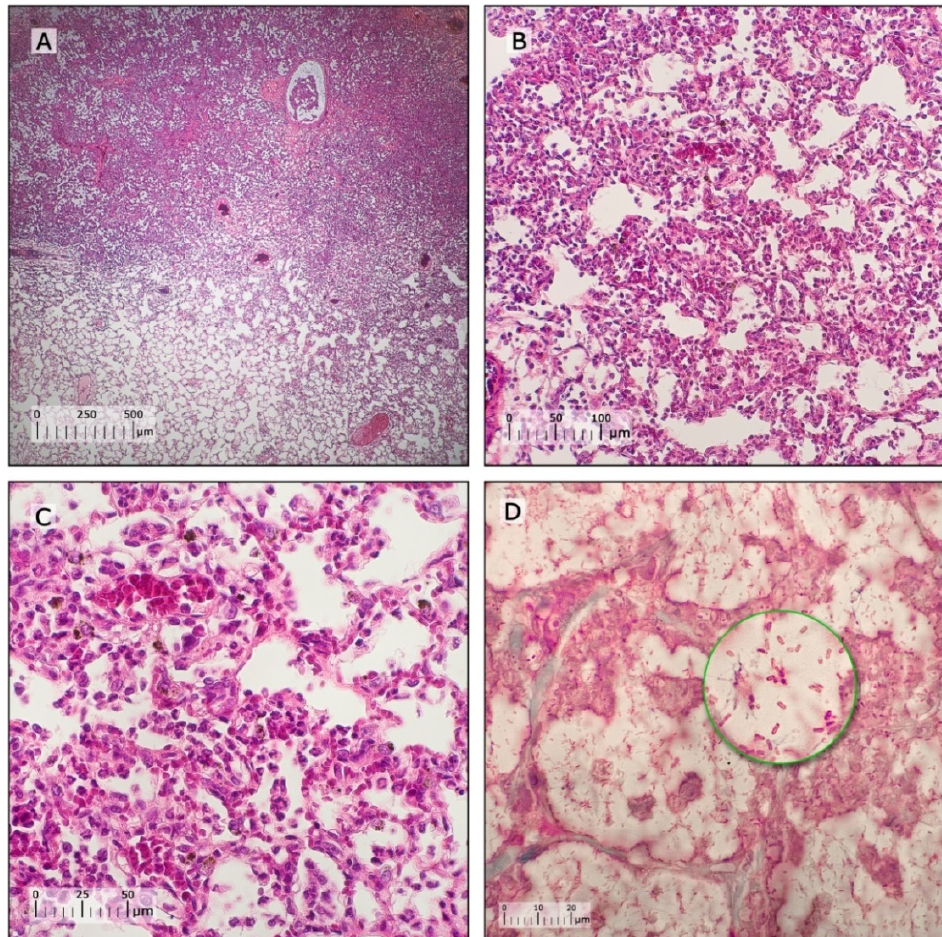
Figure A1. Representative lung histopathology in lung tissue from rats with K. pneumoniae KPC pneumonia–septicemia at 24 h after initiation of infection. ( A – C ) Sections stained with hematoxylin-eosin at different magnifications. ( D ) Section stained with Gram stain. An outer hemorrhagic zone of the lesion was observed (in areas next to uninfected tissue), in which the alveoli were filled with mucoid exudates dominated by edema fluid and a light cellular infiltrate. More extensive areas of pneumonia were observed towards the center of the lesion (i.e., in the zone of early consolidation). In these areas, alveoli were packed with predominantly polymorphonuclear leukocytes and alveolar walls were necrotic. Numerous encapsulated Gram-negative bacilli were freely present in the exudates within the hemorrhagic zone of the lesions.